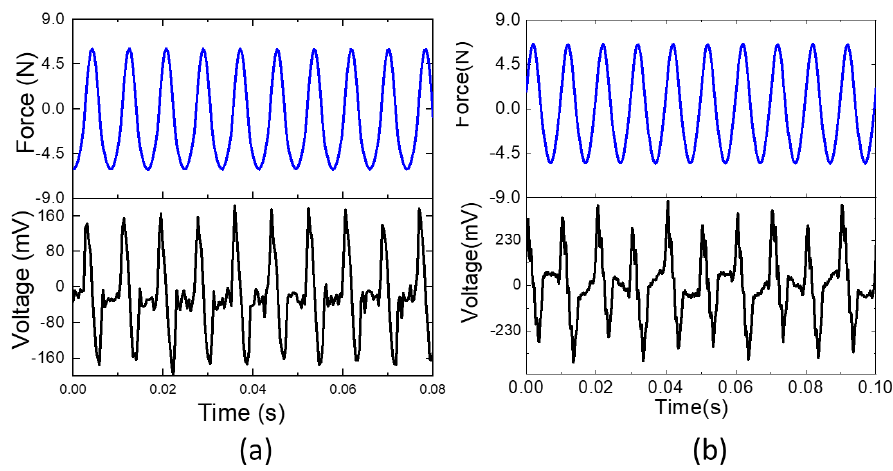
Figure 10. Input force and output voltage of ( a ) CNF film VEH; ( b ) CNF/PVA film VEH.